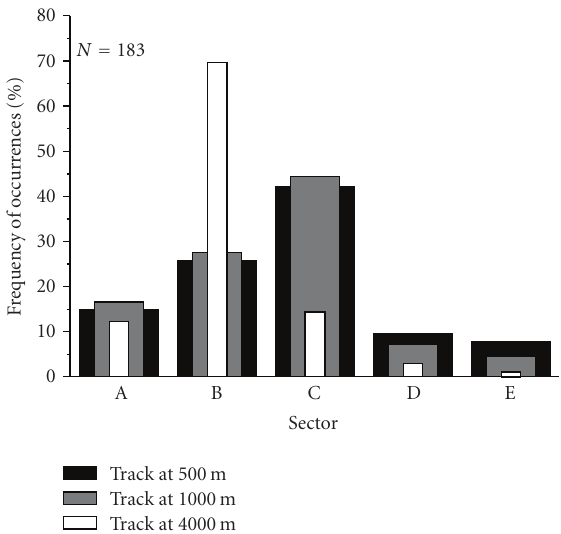
Figure 4: Same as in Figure 3, but for the CM aerosol